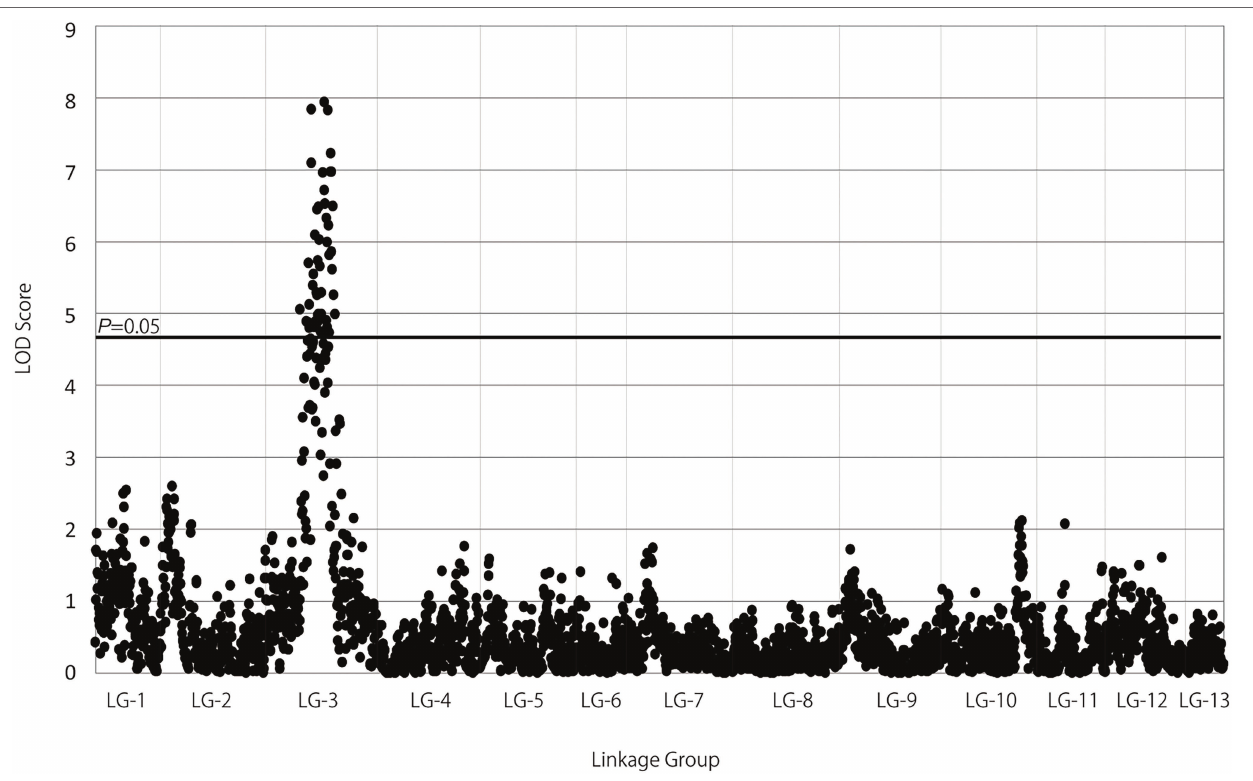
FIGURE 2 | Manhattan plot of interval mapping of LOD scores for the association between DNA marker intervals and phenotype in the NK73S1 mapping population identified significant associations with DNA markers on LG-3. The genome-wide p = 0.05 threshold for the data set was determined to be LOD = 4.8 by a permutation test run ( N = 1,000) on the genetic linkage map.